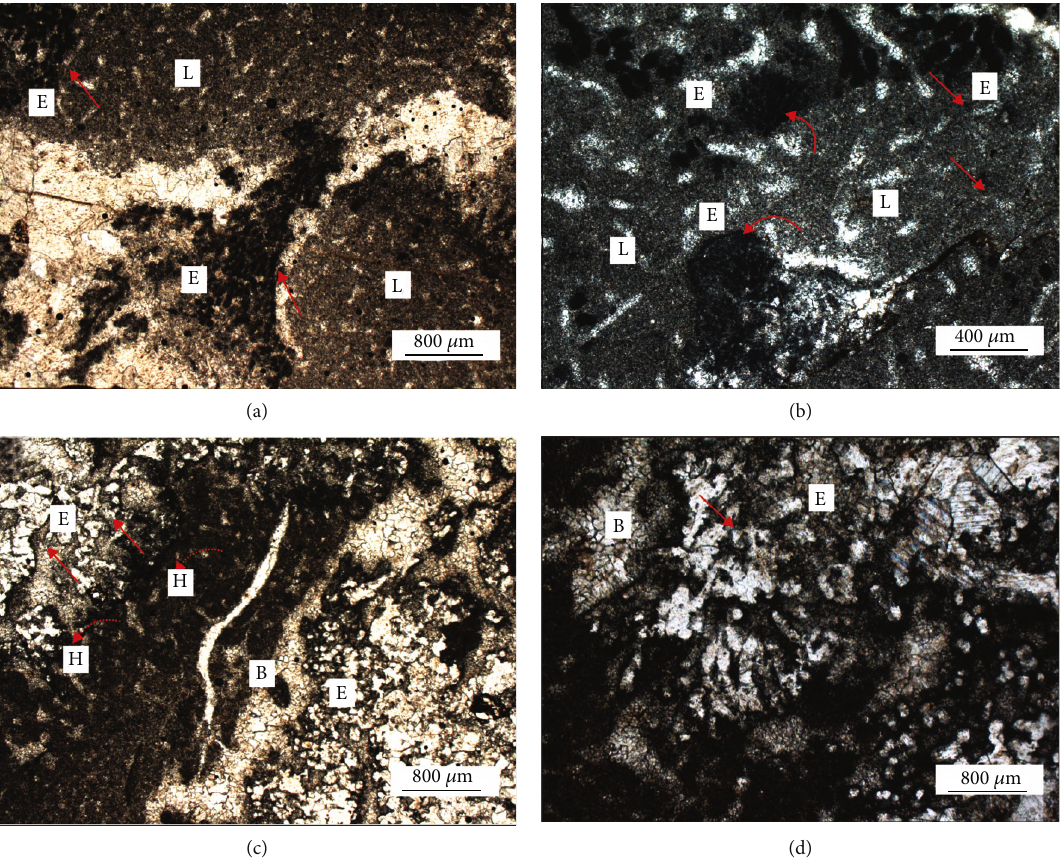
Figure 7: Micrographs of di ff erent types of Epiphyton in dendrolite of Zhangxia Formation. (a) Typical large shrubby thallus micritic coarse branches Epiphyton (E; as shown by red arrows) forming micritic dendrolite communities, possibly with a Lithocodium- like fabric (L). (b) Small micrite fi ne-branched Epiphyton (E). Branches distributed in a dense micrite matrix, microcrystalline tubular-branched Epiphyton (E) cross-section (as shown by red arrows), possibly with a Lithocodium -like fabric (L). (c, d) Sparry coarse Epiphyton (E) form sparry dendrolite communities (as indicated by red arrows) with Hedstroemia (H; as shown by red-curved arrows) symbiosis, possible Bacinella -like tissue